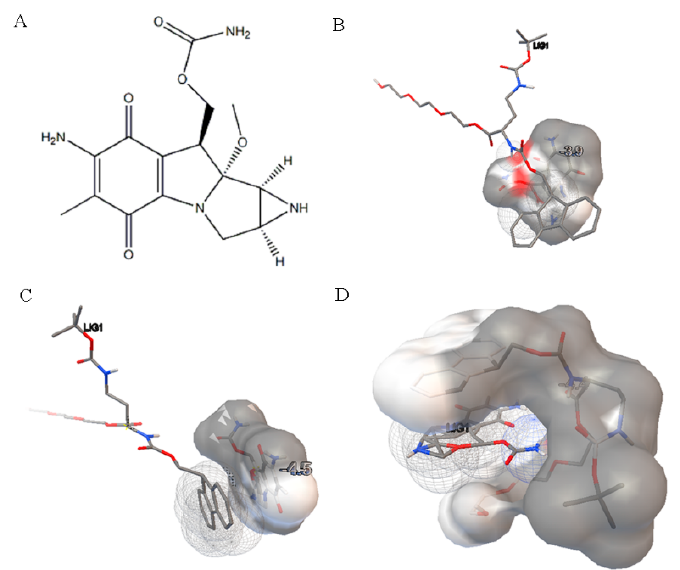
Figure 7. Prediction and analysis of the MMC-loading mechanism of nanoparticles. ( A ) The structure of MMC. ( B ) Fmoc-Lys-PEG was the ligand and MMC was the receptor. ( C ) Fmoc-Lys-PEG was the ligand and MMC was the receptor (Fmoc limited binding pocket). ( D ) MMC was the ligand and Fmoc-Lys-PEG was the